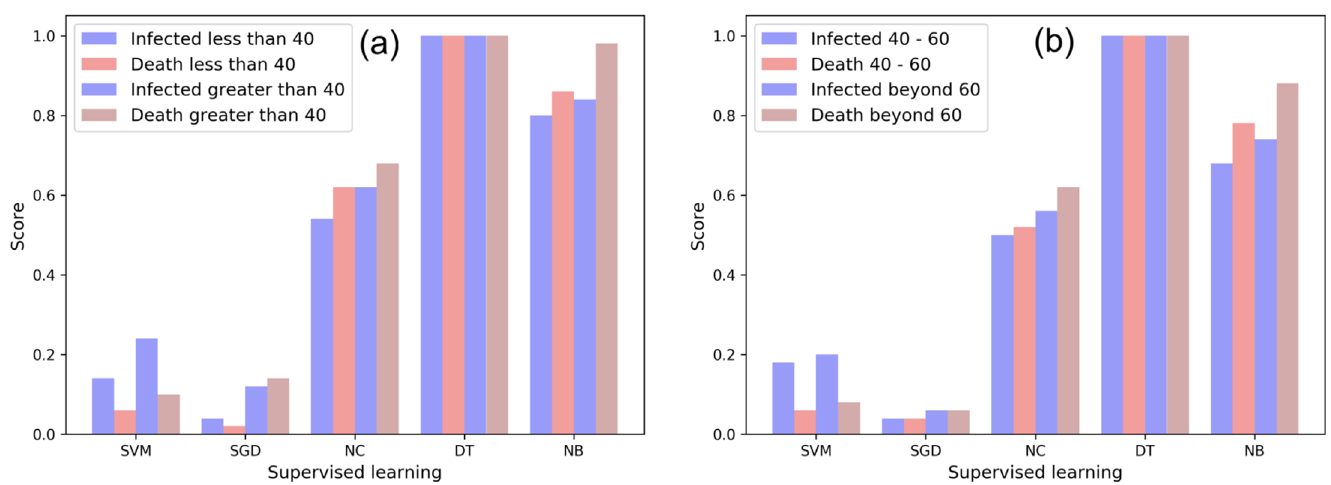
Fig 4. Effect of COVID-19 infected and death score on age: Comparison of accuracy scores for feature set of (a) age ( � 40, > 40) and (b) age (40–60, beyond 60).